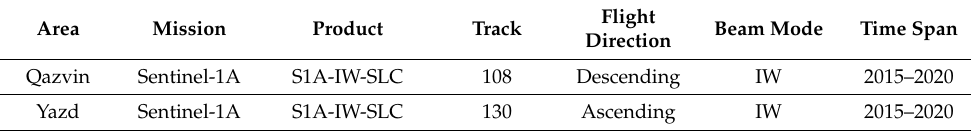
Table 2. Specifications of the radar acquisitions using